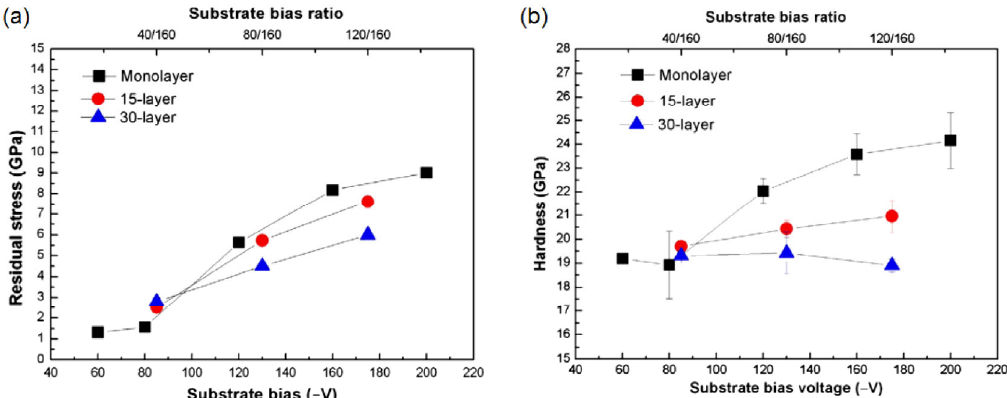
Fig. 4 (a) Residual stress and (b) hardness of coatings as a function of substrate bias and substrate bias ratio. Reprinted from Ref. [34], with permission from